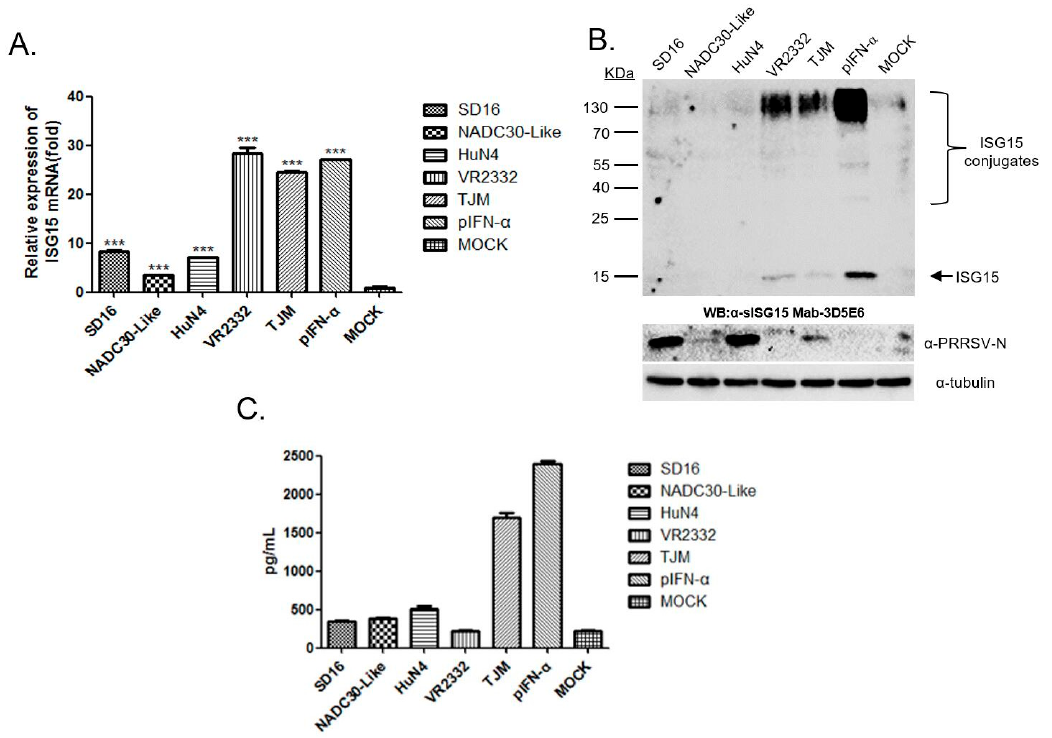
Figure 3. Low-pathogenic porcine reproductive and respiratory syndrome virus (PRRSV) infection-induced expression and secretion of extracellular ISG15 in porcine alveolar macrophages (PAMs). ( A ) PAMs were infected with different PRRSV strains for 24 h then harvested for qPCR to evaluate ISG15 mRNA levels. All experiments were repeated at least three times. Significant differences between indicated groups were marked by *** for p < 0.001. ( B ) PAMs were infected with different PRRSV strains at 1 and 2 multiplicity of infection (MOI) values for 24 h then cells were harvested and subjected to Western blot analysis to evaluate ISG15 expression and conjugation activity. PAMs without PRRSV infection or PAMs treated with pIFN- α were included as controls. Replication of PRRSV in PAMs was confirmed using anti-PRRSV-N mAB-6D10 to detect proteins on Western blot membranes. ( C ) Cell culture supernatants from PAMs infected with various PRRSV strains for 24 h were subjected to ELISA to detect levels of extracellular ISG15 secreted by PAMs. Cell culture supernatants from MOCK-infected cells and pIFN- α -stimulated PAMs were included as controls. All data are expressed as mean ± SD representing three independent